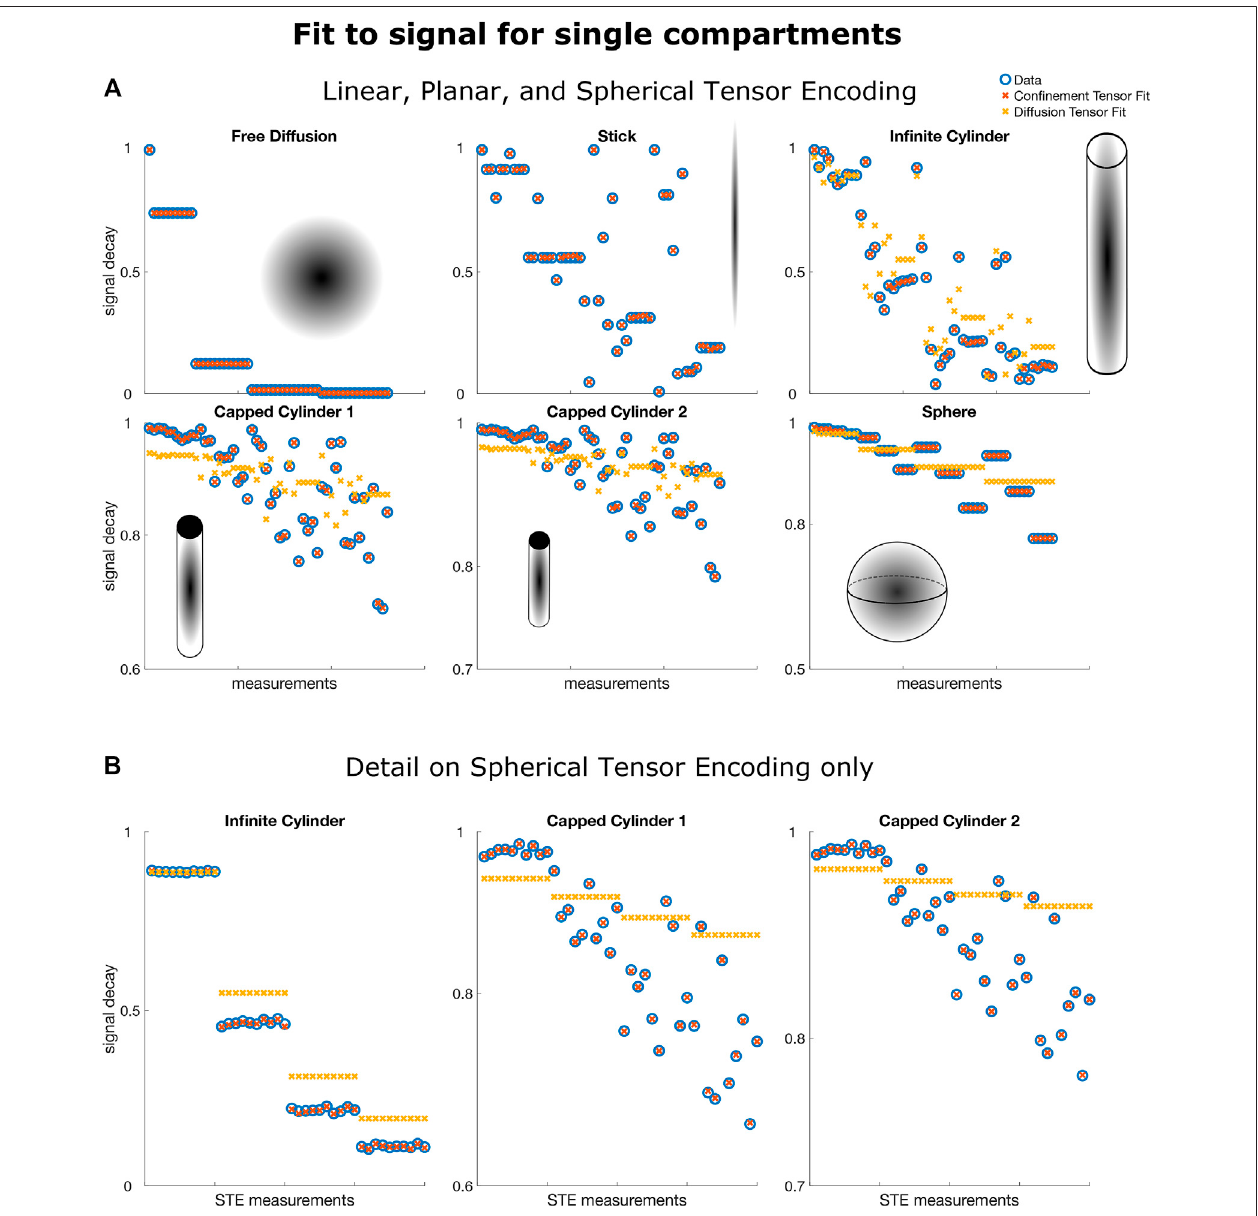
FIGURE 2 | Con fi nement and diffusion tensor fi t to signals arising from particles diffusing in free ( Free Diffusion, Stick ) and restricted ( In fi nite Cylinder, Capped Cylinder1,Capped Cylinder 2,Sphere )geometries.Inbothpanels (A,B) allthe217datapointswereused to fi tthemodel. Forease ofinterpretation,inpanel (A) only52 random points out of the 217 are shown. In panel b) all the data points produced with Spherical Tensor Encoding are shown. Note how the con fi nement tensor model captures features of diffusion in both free and restricted scenarios. In particular, observe in panel (B) how the signature of restricted diffusion imprinted on the signals produced with STE can be captured by the con fi nement tensor model while are inevitably missed by the diffusion tensor.